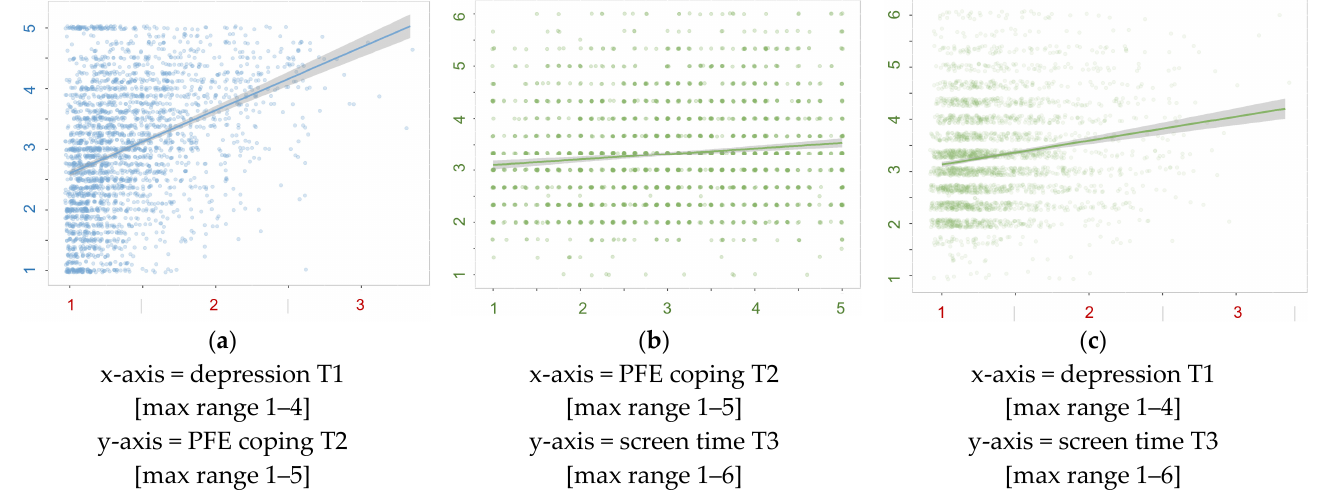
Figure A2. Bivariate plots with regression lines and with 95% CI, estimated from the structural regression data. Shows the associations of the A, B and C paths of the reversed causal directionality. ( a ) Reversed indirect effect of A-path. ( b ) Reversed indirect effect of B-path. ( c ) Reversed indirect effect of C-path.